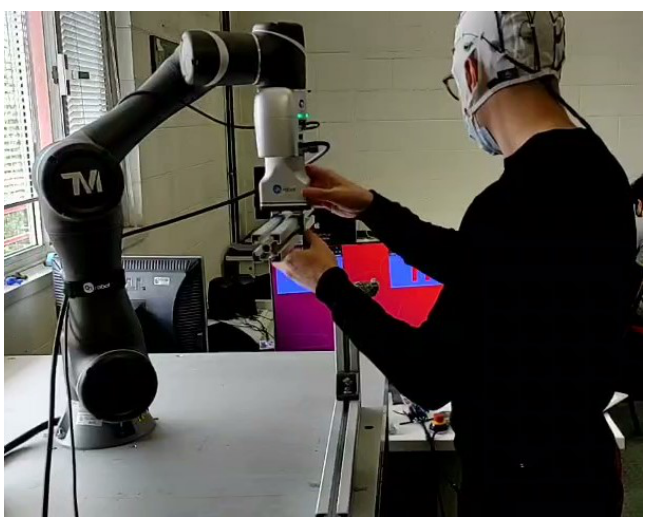
Figure 9. The operator looking at the “H” window is activating the hand guiding.